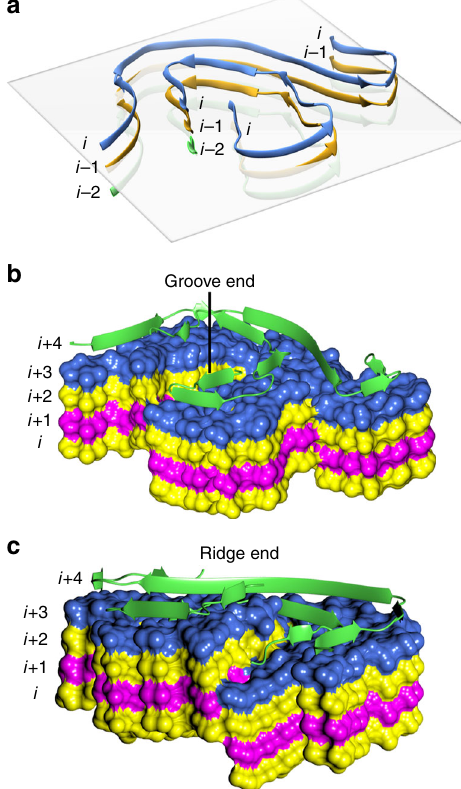
Fig. 3 Fibril subunits are not planar. a A horizontal plane (perpendicular to the fi bril elongation axis) is added to this ribbon representation of the fi bril core to highlight the raise of each subunit at the end of the β 2 strand (Pro15) and of β 5 (Trp36), respectively. b , c A structural view of the fi bril ends: the inner core concave region (groove) is shown in b ; the inner core ( β 1 – β 2) of the fi bril is shown in c protruding from the surface (ridge). Different colors are used for independent subunits